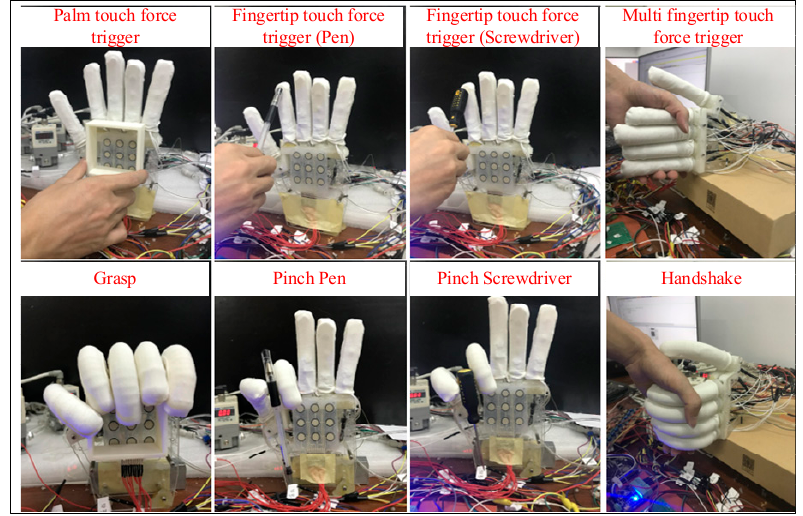
Figure 7. The validation experiment of TDO. The results of trigger state detection are shown in Figure 8.